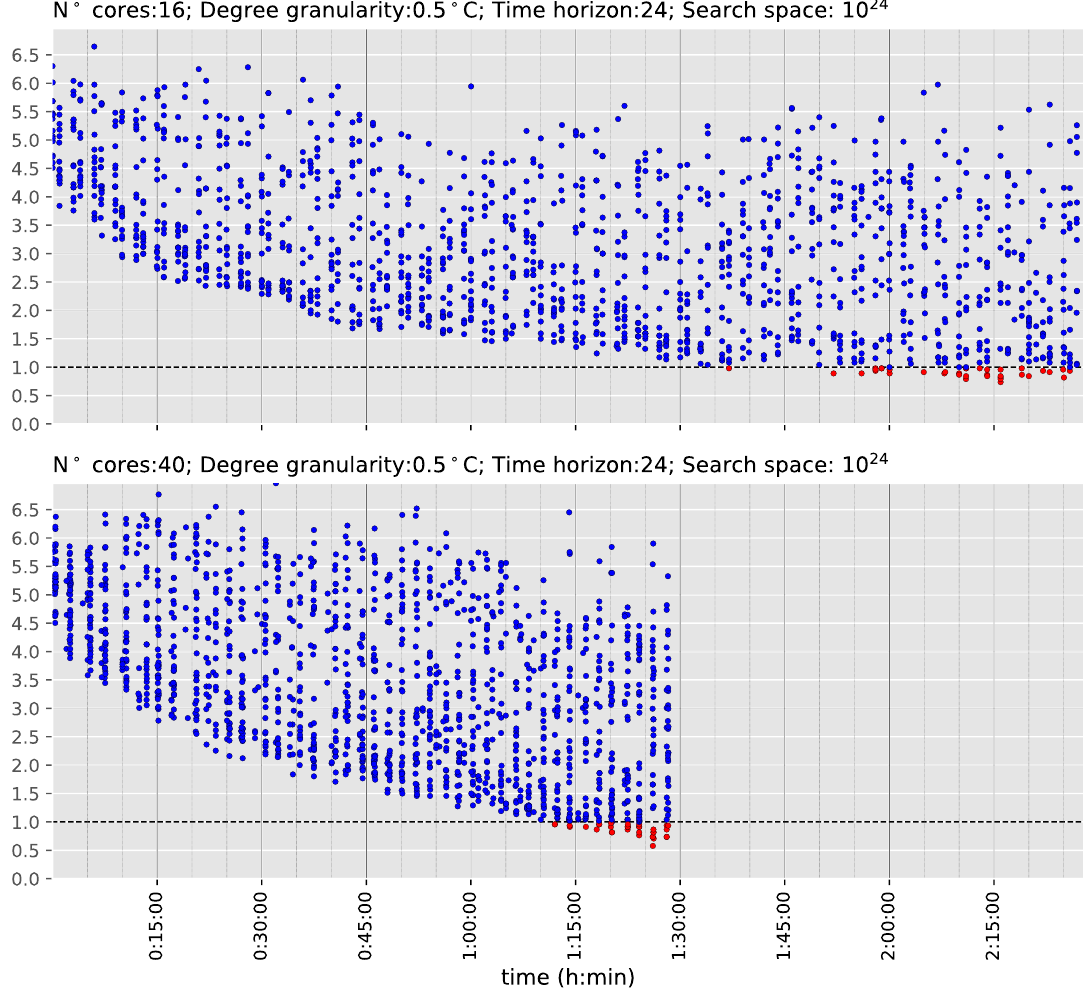
Figure 8. Second experiment: MPC results with free oscillation curve consideration for search space reduction (standard computer ( top ) and workstation ( bottom